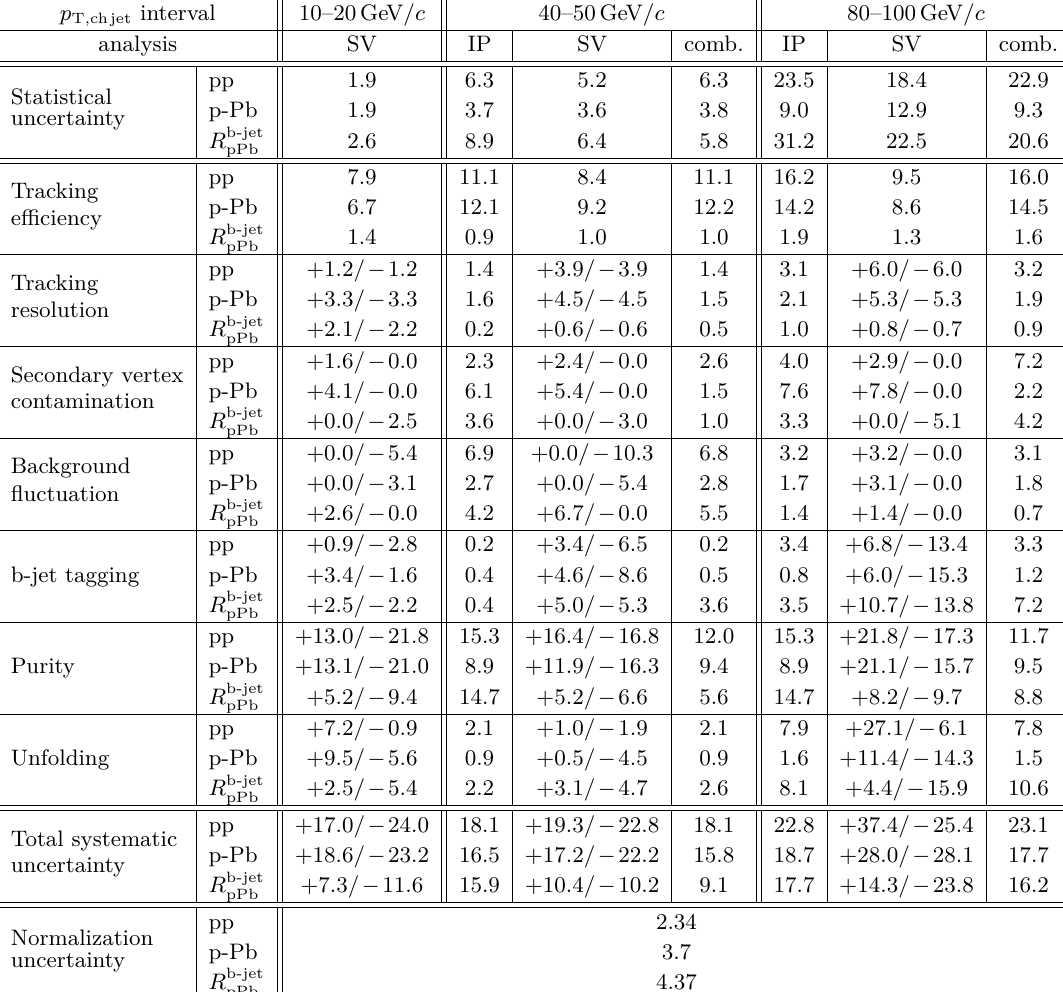
Table 2. Statistical and systematic uncertainties, in percent, corresponding to three representative p T , chjet ranges for the pp and p-Pb cross sections, as well as for the R b-jet the IP and SV methods are quoted separately. Wherever applicable, the table also reports the resulting combined uncertainties. Both the upper and lower values are listed for the asymmetric SV systematic uncertainties. An additional uncertainty from the normalization by the integrated luminosity [40, 41] is quoted in the last